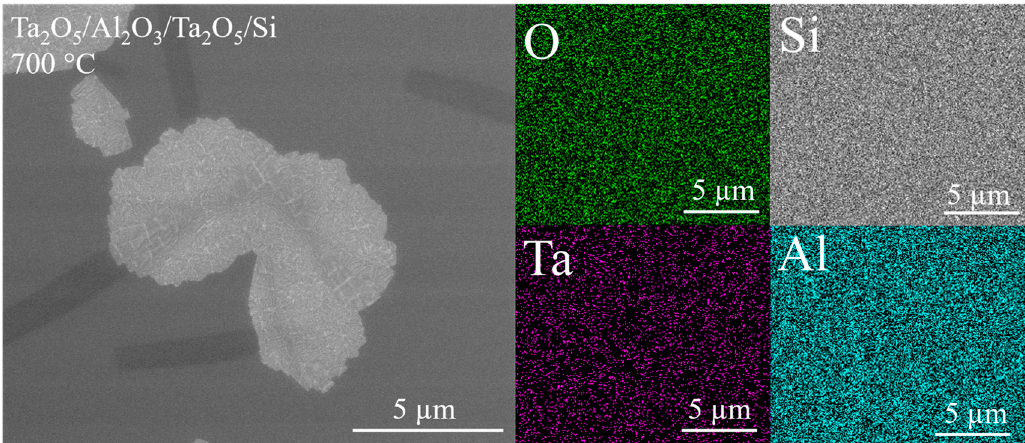
Figure 5. Spatial element (O, Si, Ta, Al) distribution measured with EDX on grain-like surface features of Ta 2 O 5 /Al 2 O 3 /Ta 2 O 5 film after annealing at 700 ◦ C.